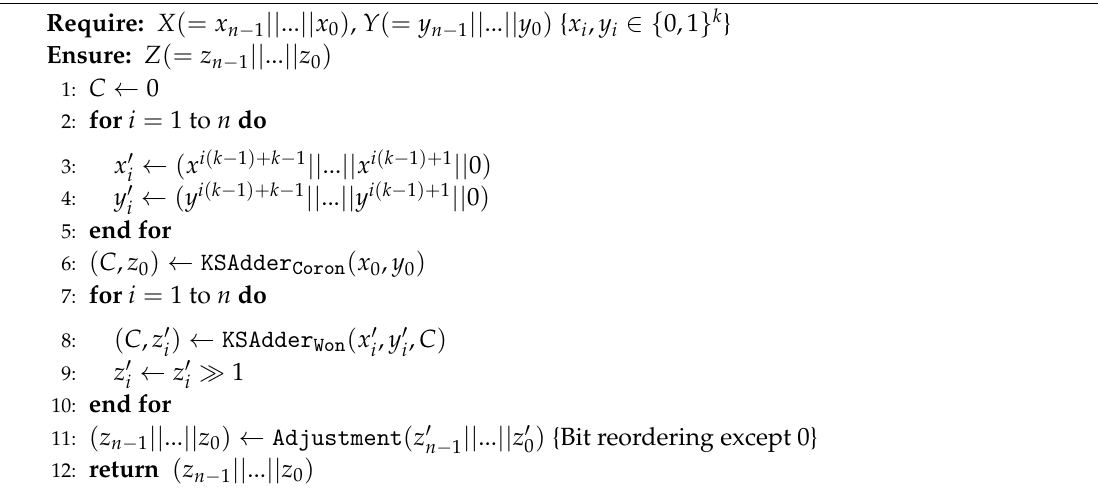
Algorithm A5: Modified Won’s Multi-bit Adder Combining Kogge–Stone